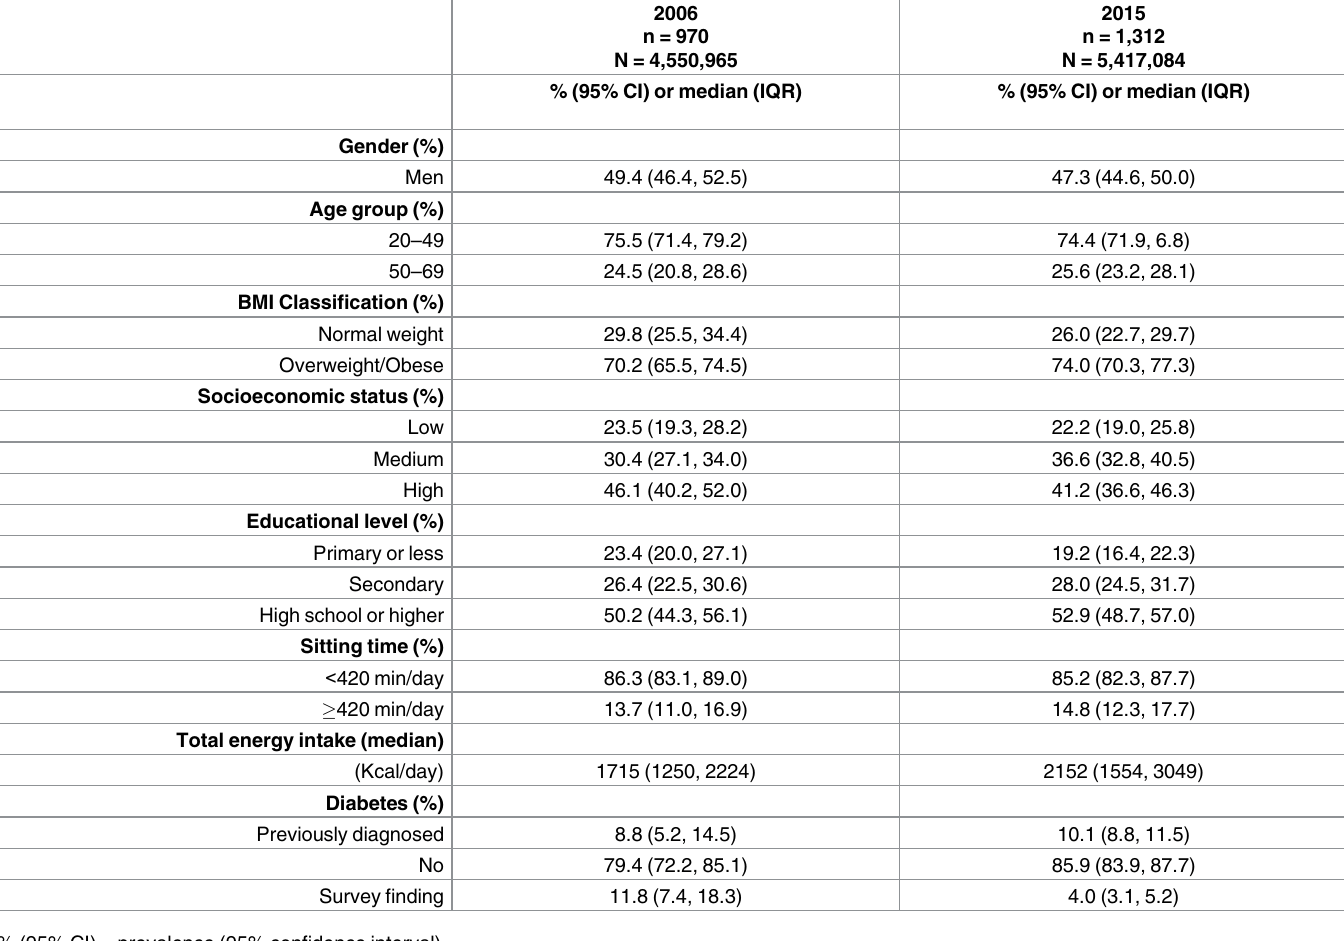
Table 1. Sociodemographic and anthropometric characteristics of the analytic sample of adults aged 20–69 yearsin Mexico City (ENSANUT 2006 and MCDRS